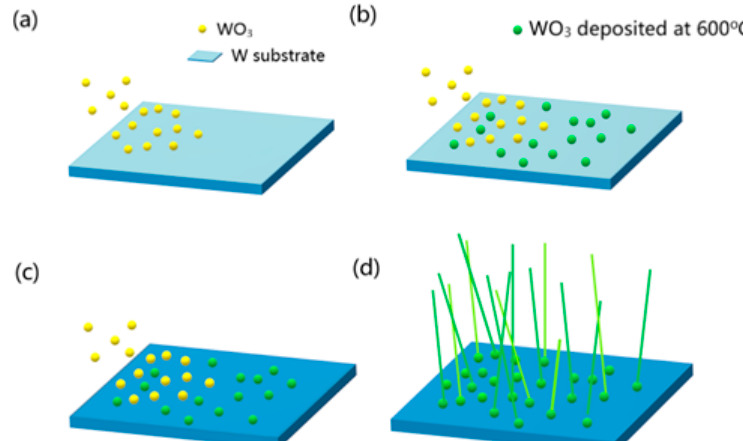
Figure 2. The growth mechanism of thermal evaporation. ( a ) The tungsten trioxide vapor moved to the substrate by the carrier gas. ( b ) The tungsten trioxide vapor effectively collided with the tungsten substrate and nucleated on the substrate. ( c ) Formation of a dark blue film of tungsten oxide on the substrate. ( d ) Tungsten trioxide nanowires were grown from the protrusions of the film as nucleation points.